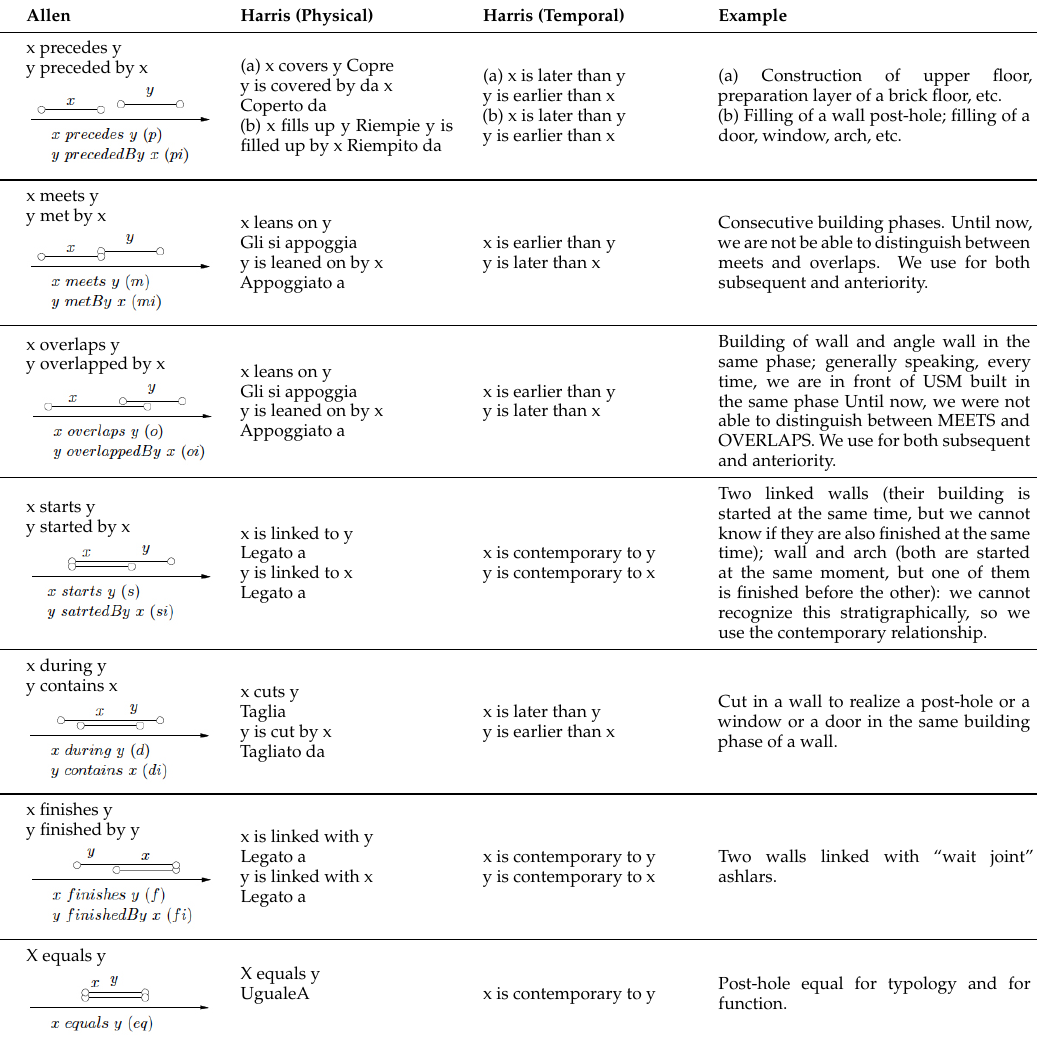
Figure 3. Allen’s intervals algebra atomic relations.